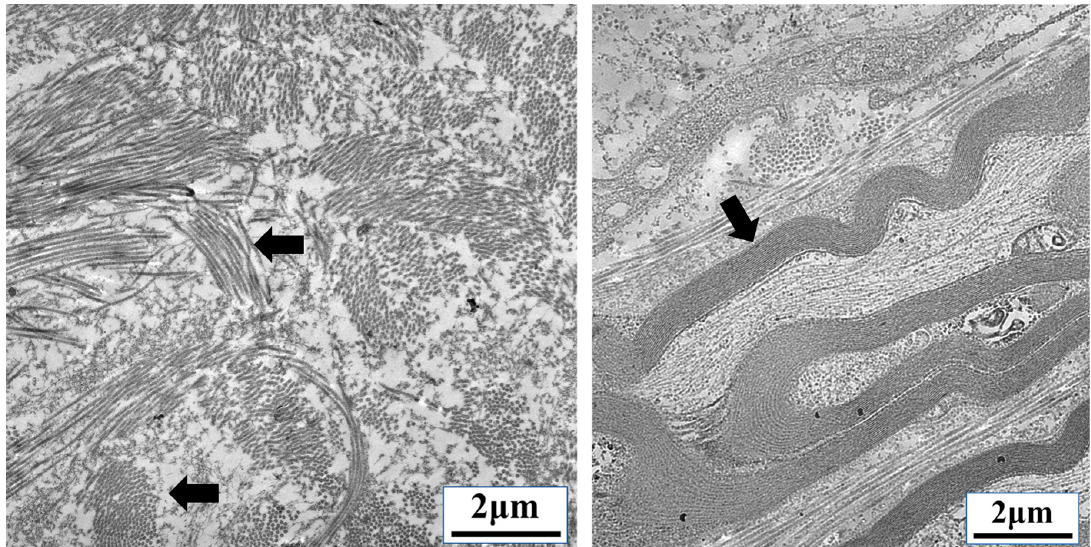
Figure 4. Extracellular matrix (ECM) interactions provide mechanical cues to infiltrating cells. ECM remodeling is required for tumor proliferation, metastasis, angiogenesis, and leukocyte infiltration. The image on the left shows a region with multidirectional bundles of collagen (arrows). The image on the right shows highly organized bundles of parallel collagen fibers found in body (arrow). Dense collagen networks such as these found in capsular regions of lymphoid tissue can be found within the tumor microenvironment. Collagen induced by transforming growth factor β (TGF- β ) and other factors provide structural support to cancer cells and a physical barrier to leukocytes. (Transmission electron microscopy images taken by our group.)